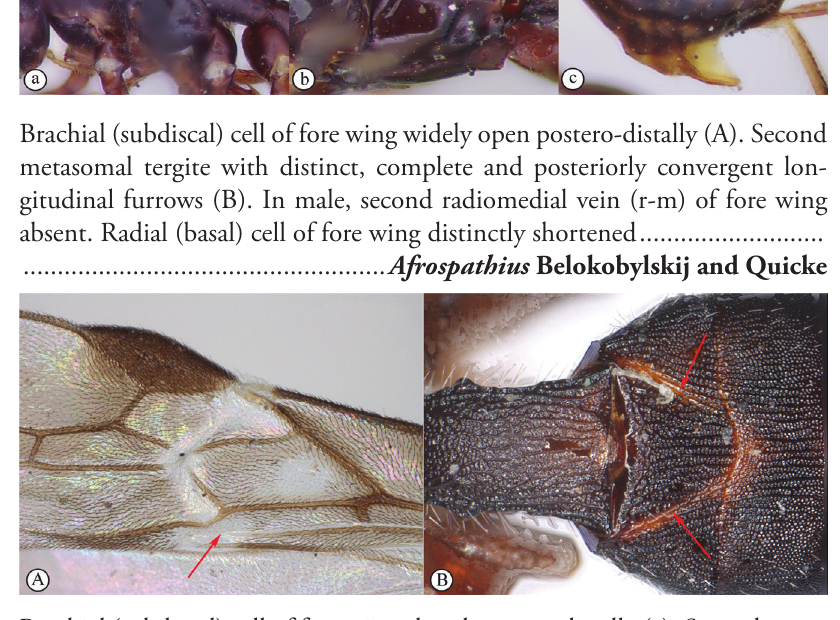
– Brachial (subdiscal) cell of fore wing closed postero-distally (a). Second meta- somal tergite without longitudinal furrows (b). In male, second radiomedial vein (r-m) of fore wing present. Radial (basal) cell of fore wing not